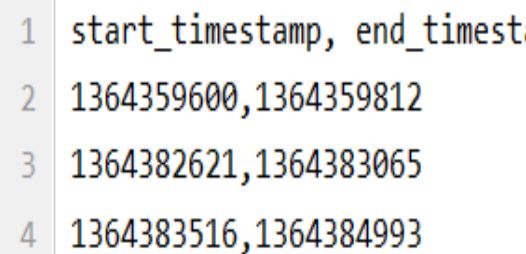
Figure 8. Dataset features used in the